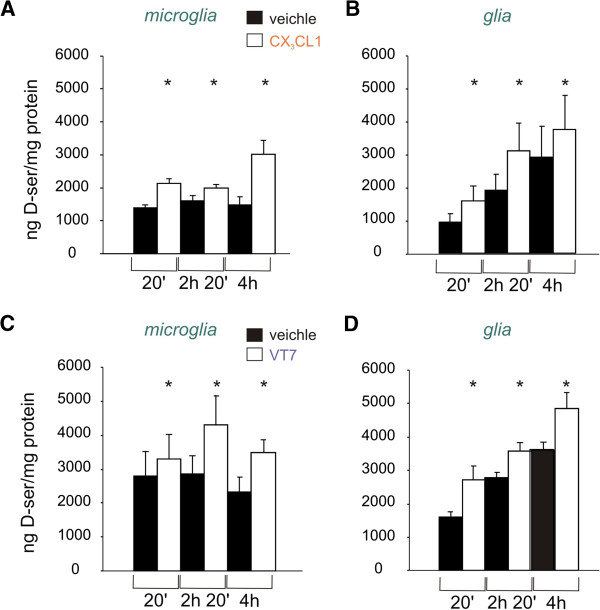
CX3CL1 and 5-(6-amino-2-(phenethylthio)-9H-purin-9-yl)-N-ethyl-3,4-dihydroxytetrahydrofuran-2-carboxamide (VT7) induce extracellular accumulation ofd-serine. Mass spectroscopy analysis of d-serine levels in primary purified microglia or mixed glia culture medium (A,B). Cells were stimulated with CX3CL1 (10 nM) or vehicle and after 20 minutes, 2 h and 20 minutes or 4 h (as indicated) medium was collected and analyzed for d-serine content. Results are expressed as ng extracellular d-serine accumulated per mg of cellular proteins and are the mean ± SEM of eight independent experiments. (A) Shows purified microglia, (B) shows mixed glia culture medium. (C,D) Cells stimulated with VT7 (50 nM) plus adenosine deaminase (ADA, 1 U/ml) or vehicle (ADA, 1 U/ml) and samples collected as in (A,B). (C) Shows purified microglia, (D) shows mixed glia culture medium. Results are the mean ± SEM of nine experiments (C) or 12 experiments (D). White square, vehicle; black square treatment, as indicated. *P <0.05.